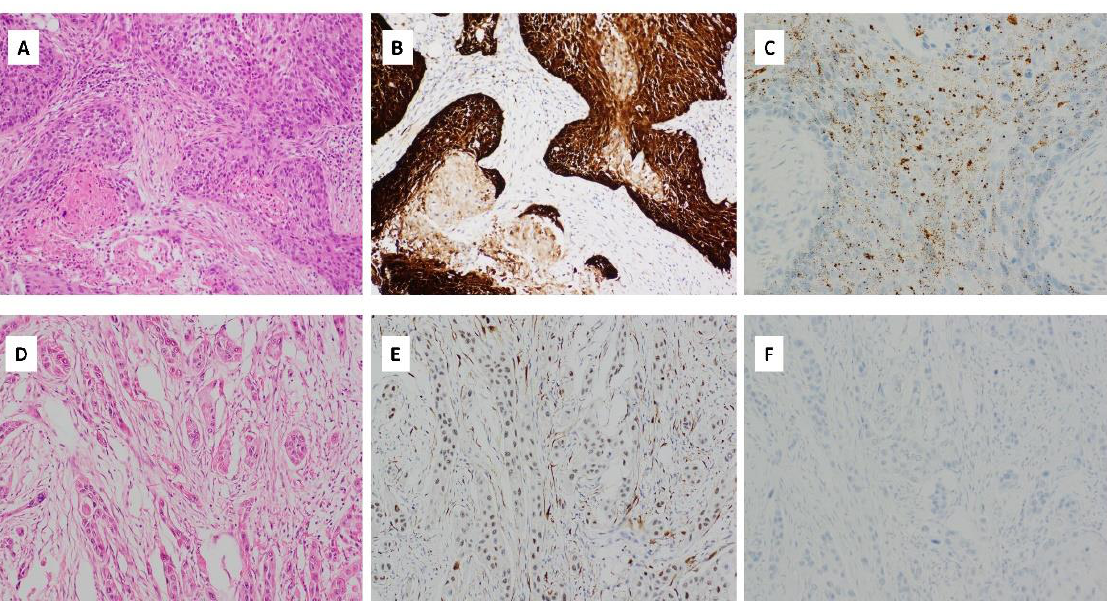
Figure 5. ( A ) Haematoxylin and eosin (H&E) stained sections of OSCC with HPV integration. There are expanded nests of keratinocytes with scanty cytoplasm and angulated hyperchromatic nuclei. Comedonecrosis is seen. There is scanty keratinization at the periphery of the nests (magnification × 400); ( B ) p16 immunohistochemical staining, showing strong, cytoplasmic and nuclear block-like positive staining in >75% of the cells (magnification × 400); ( C ) HPV RNA ISH demonstrating punctate tumour cell staining (magnification × 400); ( D ) H&E stained section of OSCC with weak/patchy p16 immunohistochemical staining (magnification × 400); ( E ) p16 immunohistochemical staining with patchy weak p16 staining considered negative for p16 (magnification × 400); ( F ) HPV RNA ISH demonstrating lack of HPV integration (magnification × 400). Table 1. Cohort summary.